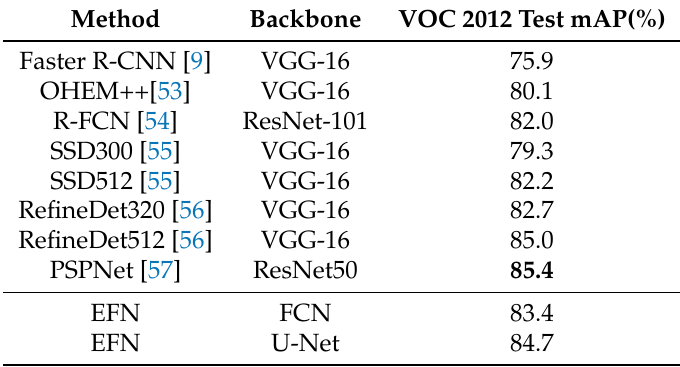
Table 7. Comparison with prior works on VOC 2012. All methods were trained on VOC 2007 and VOC 2012 trainval sets plus the VOC 2007 test set, and were tested on the VOC 2012 test